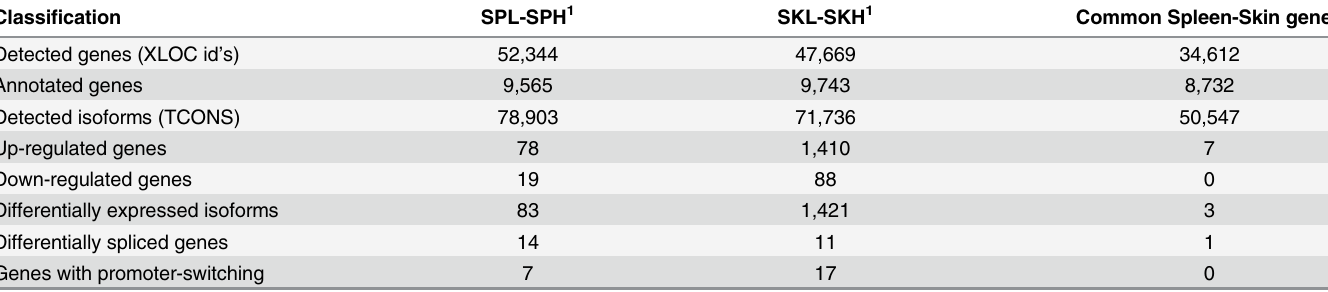
Table 3. Statistics of genes differentially expressed between individuals with high and low